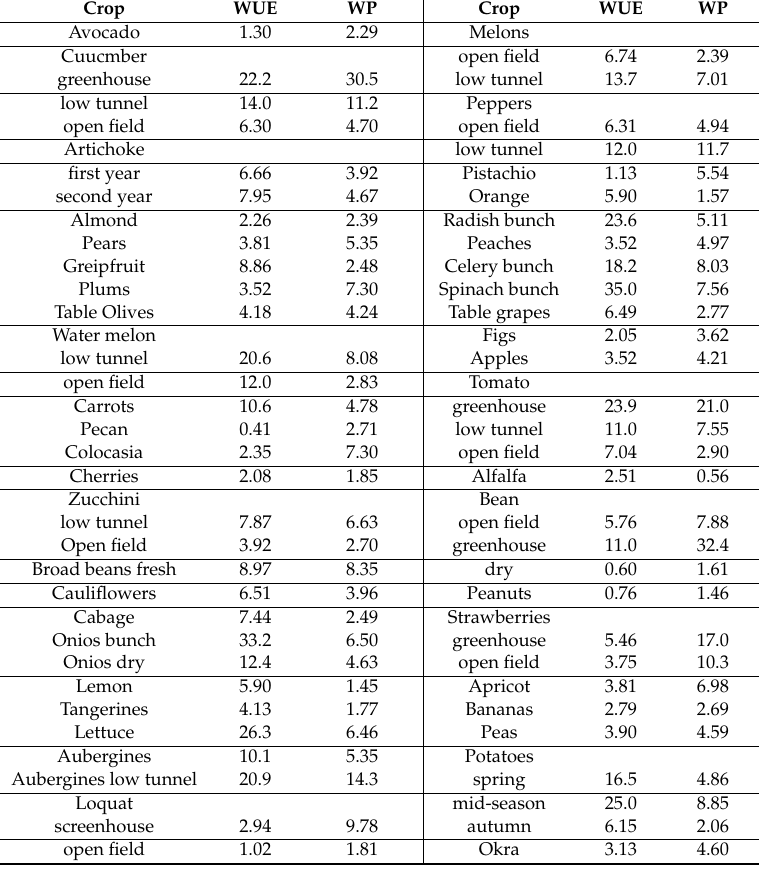
Table 5. Water Productivity (WP; € m − 3 ) and Water Use E ffi ciency (WUE; Kg m -3 ) values of several crops estimated based on market prices and crop water needs